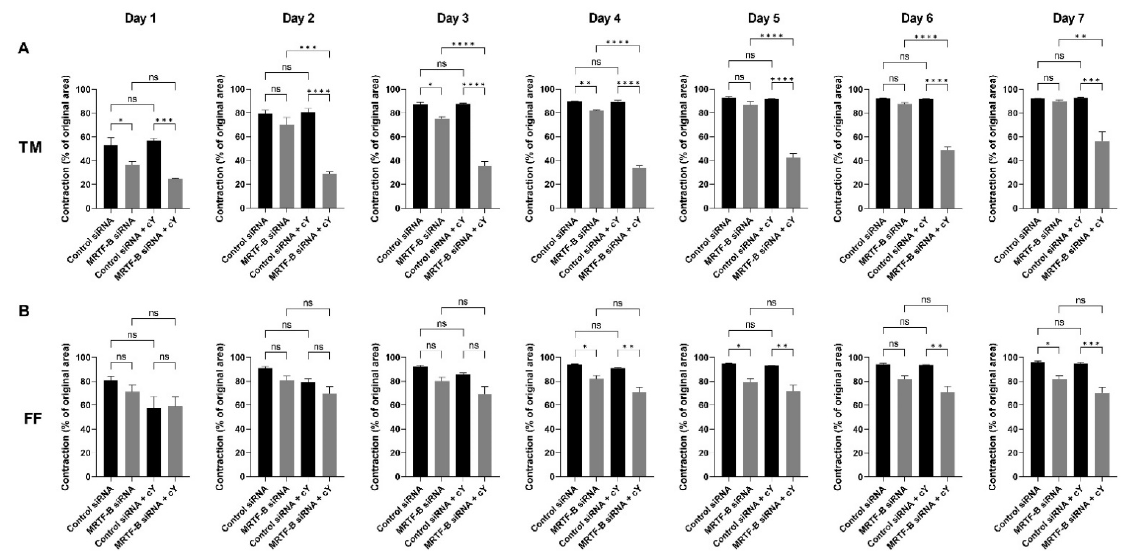
Figure 7. Collagen contraction assay of human ( A ) TM and ( B ) FF cells after transfection with four lipid nanoparticles (LNP ‐ Control siRNA, LNP ‐ MRTF ‐ B siRNA, LNP ‐ Control siRNA + c Υ , LNP ‐ MRTF ‐ B siRNA + c Υ ) throughout the 7 days. The percentage contraction was calculated from the original area on day 0. Results represent mean ± SEM. n = 3. *, p < 0.05; **, p < 0.01; ***, p < 0.001; ****, p < 0.0001; ns, not